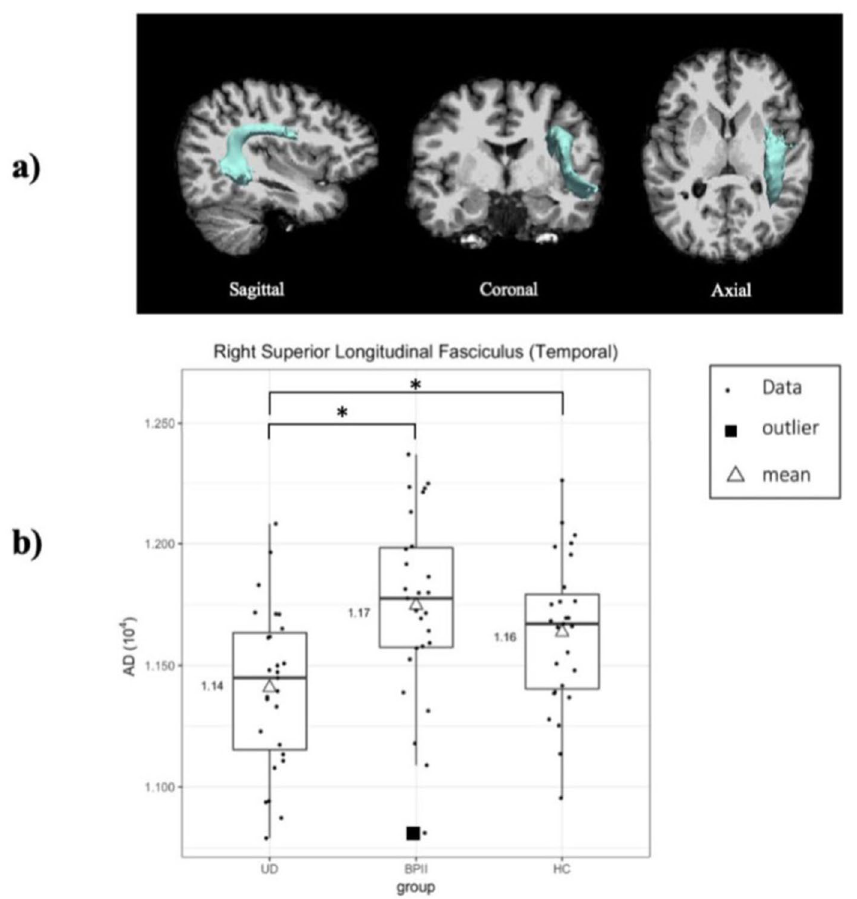
Figure 1. ( a ) Right superior longitudinal fasciculus (temporal) overlaid on the T1-weighted MR images (in native space) of a representative subject. Pathway was retrieved from the 4D volume provided by TRACULA. ( b ) Box plots of axial diffusivity at the right superior longitudinal fasciculus (temporal).